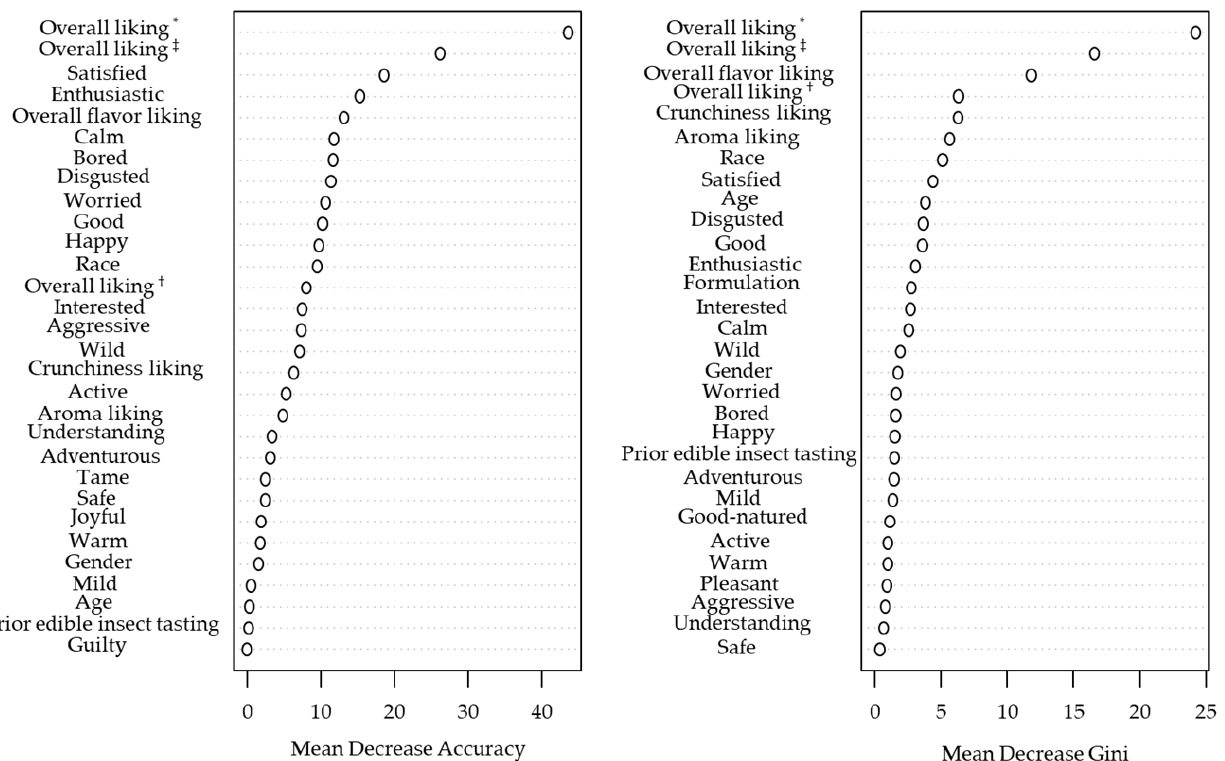
Figure 10. Random forest classifier variables importance plots for after-tasting (after edible cricket protein (ECP) statement) purchase intent (PI) prediction. † Before-tasting moment; ‡ after-tasting (before ECP statement) moment; * after-tasting (after ECP statement) moment. Emotions included in the model were from the after-tasting (after ECP statement) moment.